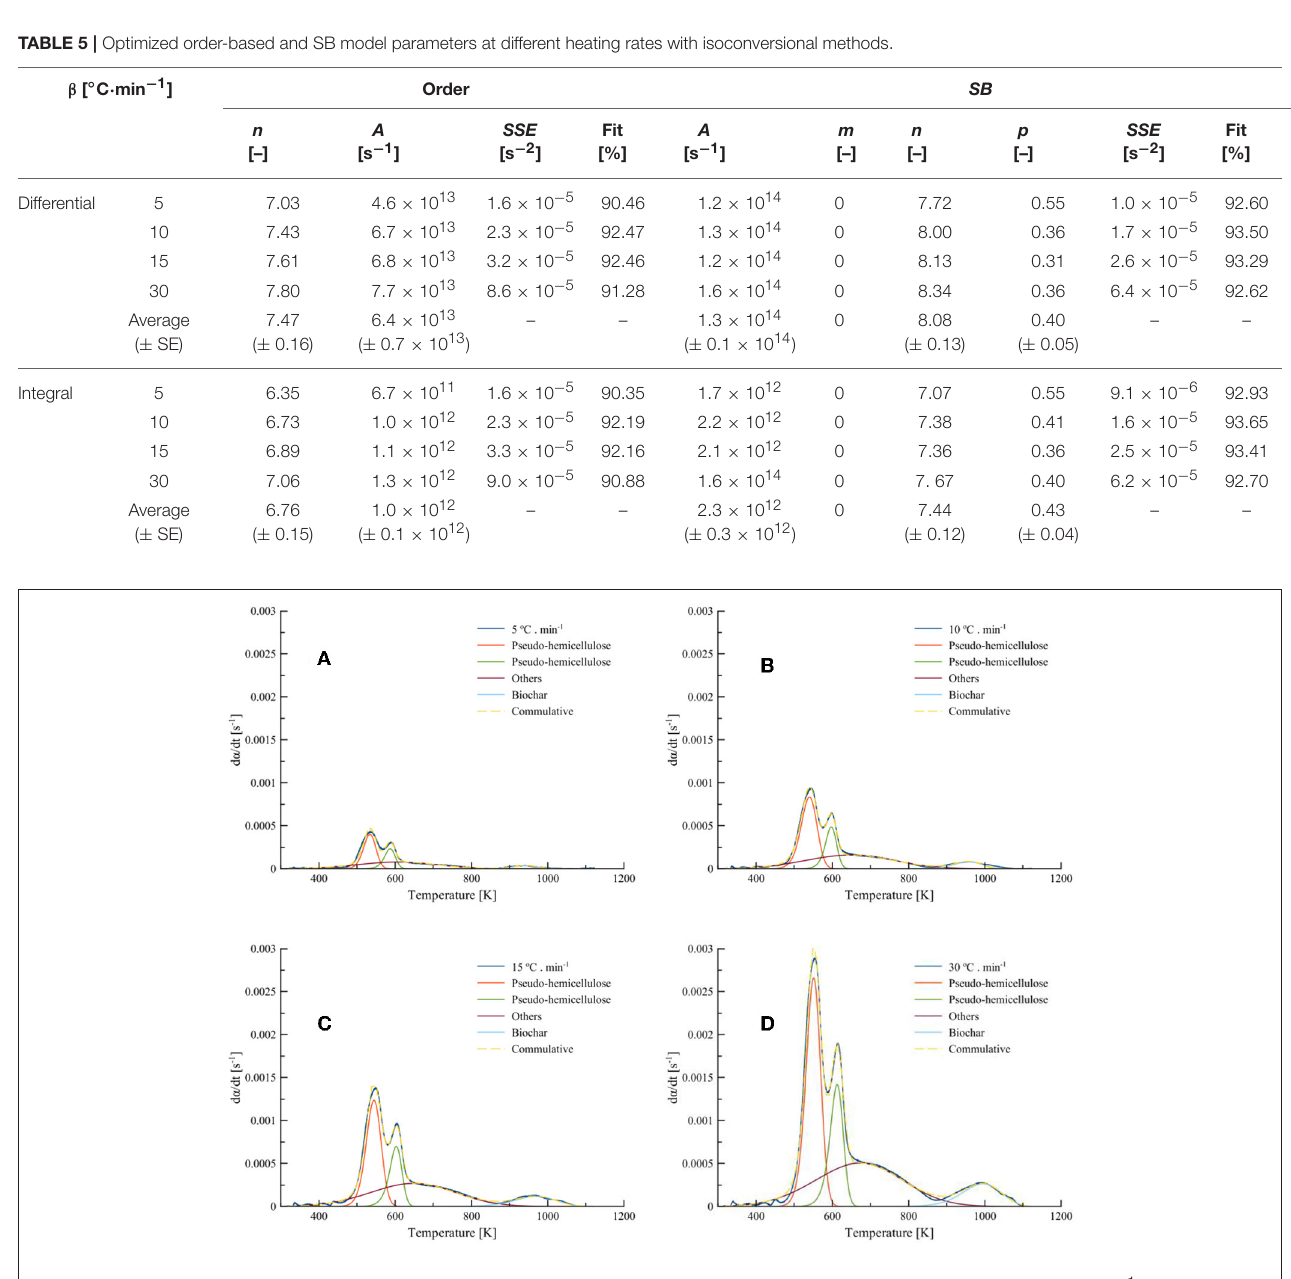
FIGURE 6 | Model-fitting of Turbinaria ornata with three pseudo-components and biochar degradation at (A) 5; (B) 10; (C) 15; and (D) 30 ◦ C